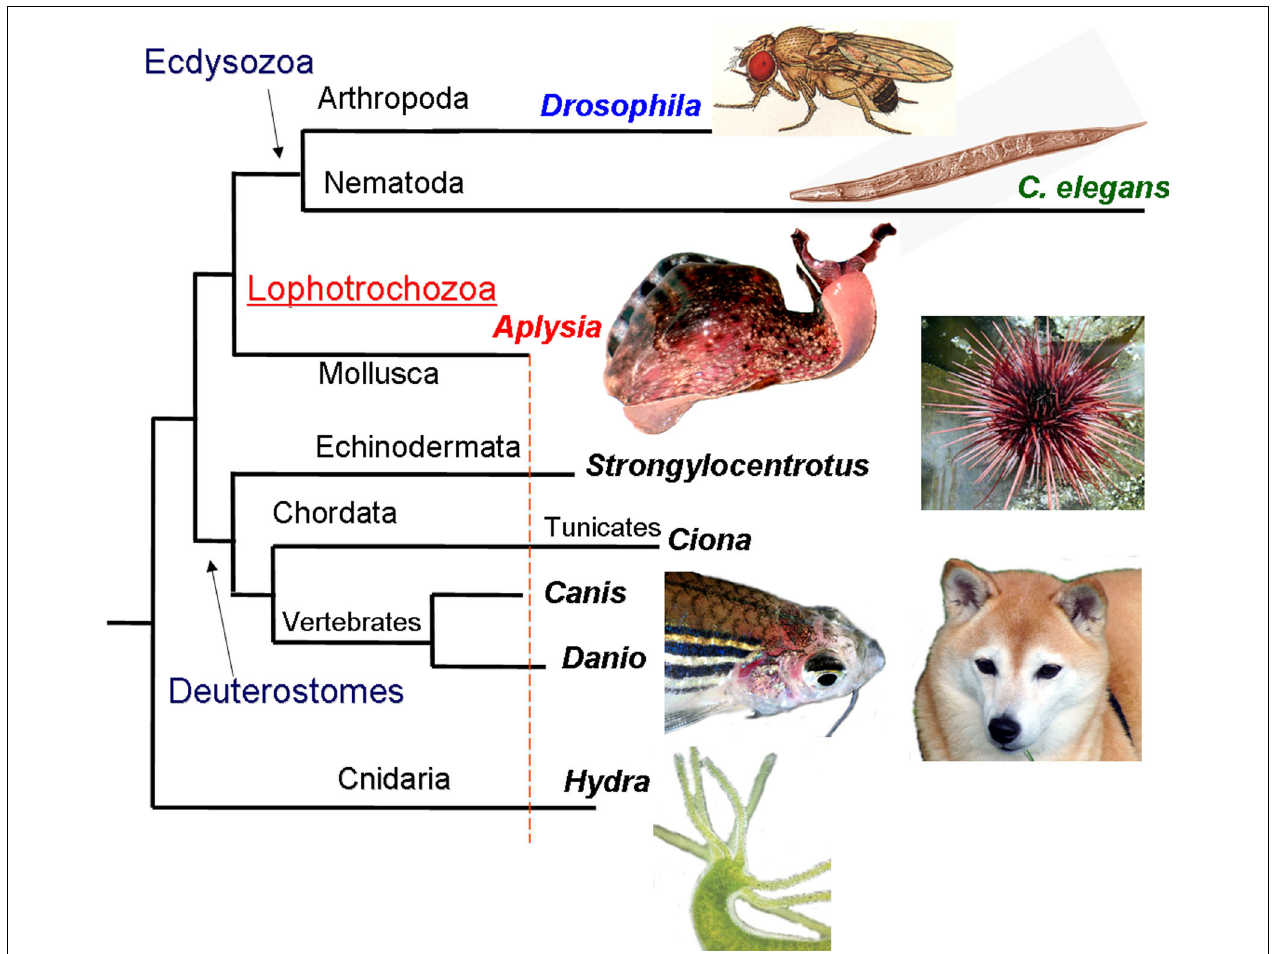
FIGURE 1 | The phylogenetic position of Aplysia among other model organisms. Apparently, the mollusc Aplysia has a relatively slower evolving genome compared to other model organisms such as tunicates, sea urchins, cnidarians, nematodes and insects, with remarkable similarity found between Aplysia and mammals (modifi ed from Moroz et al., 2006; Moroz, 2009; Walters and Moroz, 2009). The lengths of different branches refl ect the amino acid replacement rate for 66 KOG genes (a cluster of evolutionarily conserved genes among eukaryotes). The longer branches (e.g., for the representatives